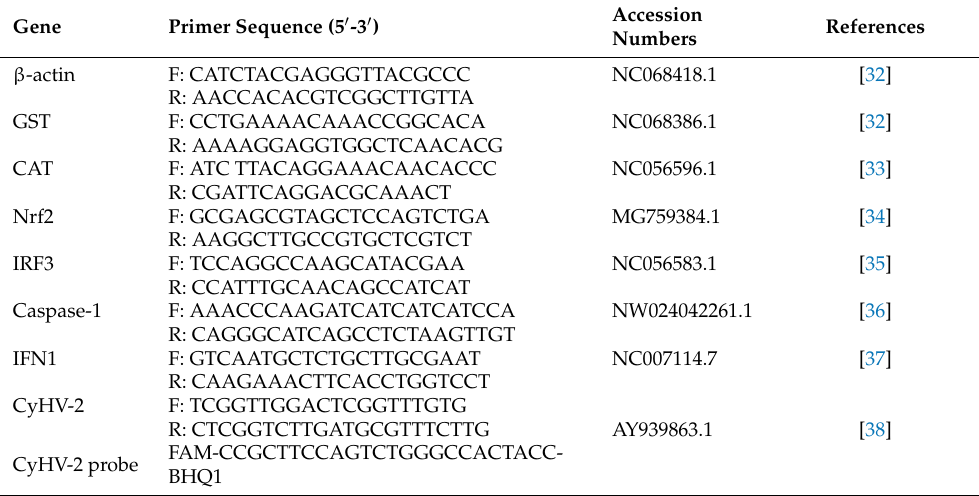
Table 1. Primer sequences used in this